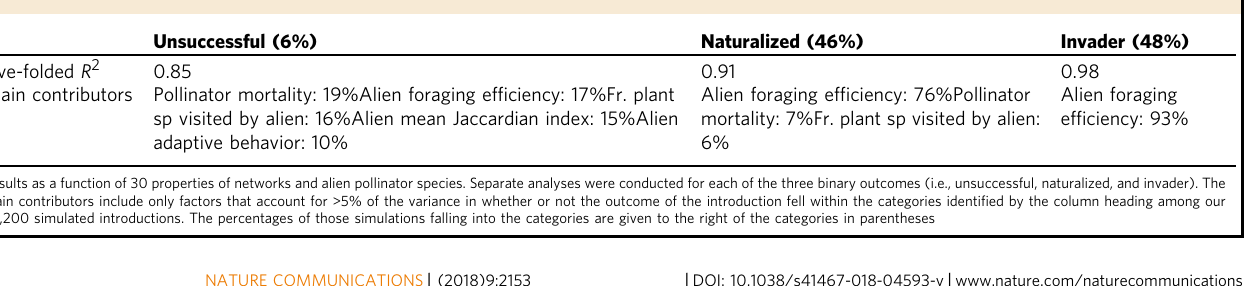
Table 1 Classi fi cation and regression tree (CART, n = 43,200) analyses of introduction